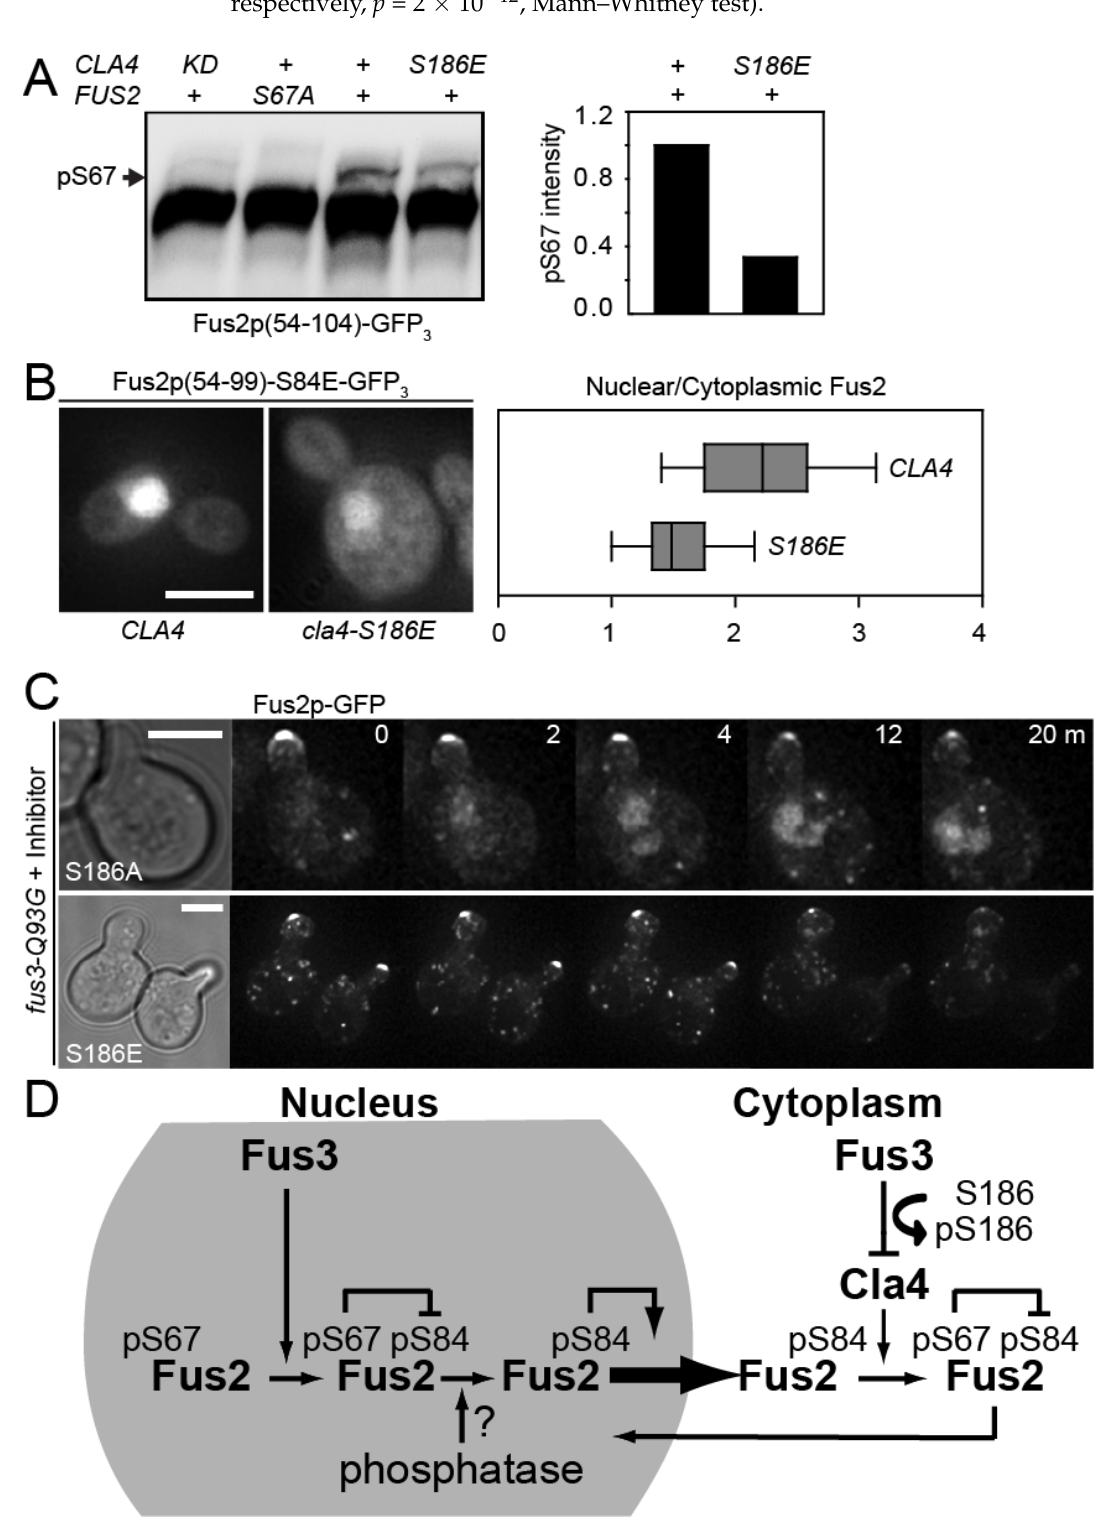
Figure 5. In vivo effects of Cla4 ‐ S186 phosphorylation. ( A ) Fus2p 54 − 104 ‐ GFP 3 (MR6009) and Fus2p 54 − 104 ‐ S67A ‐ GFP 3 (MR6166) were expressed from the GAL1 promoter for 90 min in strains MY15363, 15364, 15365, and 15366. Samples were separated on a 50 μ M Phos ‐ tag gel and detected by anti ‐ GFP. The S67 phosphorylated species (arrow) was quantified relative to wild ‐ type Cla4p (right panel). ( B ) Fus2p 54 − 99 ‐ S84E ‐ GFP 3 (MR6160) was expressed from the GAL1 promoter for 90 min in MY15355 and 15356. The intensity of nuclear fluorescence relative to an equal cytoplasmic area was measured in live cells (n = 52 for the cla4 ‐ S186E mutant and 181 for the CLA4 wild ‐ type), as described in the Materials and Methods. ( C ) Full length Fus2p ‐ GFP was examined over time in fus3 ‐